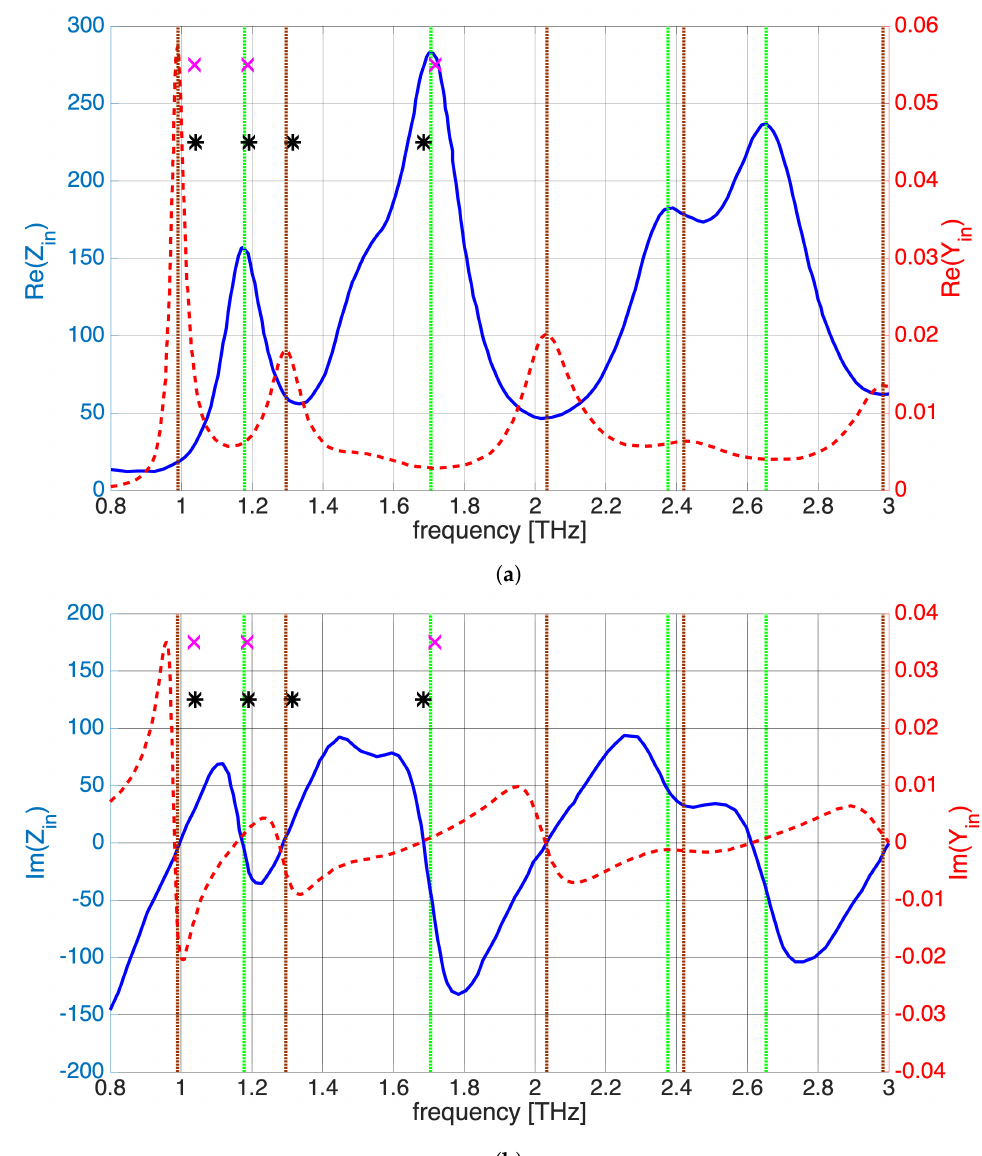
Figure 10. ( a ) Real and ( b ) imaginary parts of input impedance (blue solid lines) and admittance (red dashed line) responses for the patch antenna when it is de-embedded at the line–patch interconnection (see Figure 9), as simulated in CST Studio Suite [71]. Vertical green dotted lines mark the maximum input impedance, while brown dotted lines mark the maximum input admittance. The fuchsia crosses represent the resonances resulted from the eigenanalysis of the terahertz patch antenna without the feeding line, while the black stars represent the resonances from the eigenanalysis with the presence of the feeding